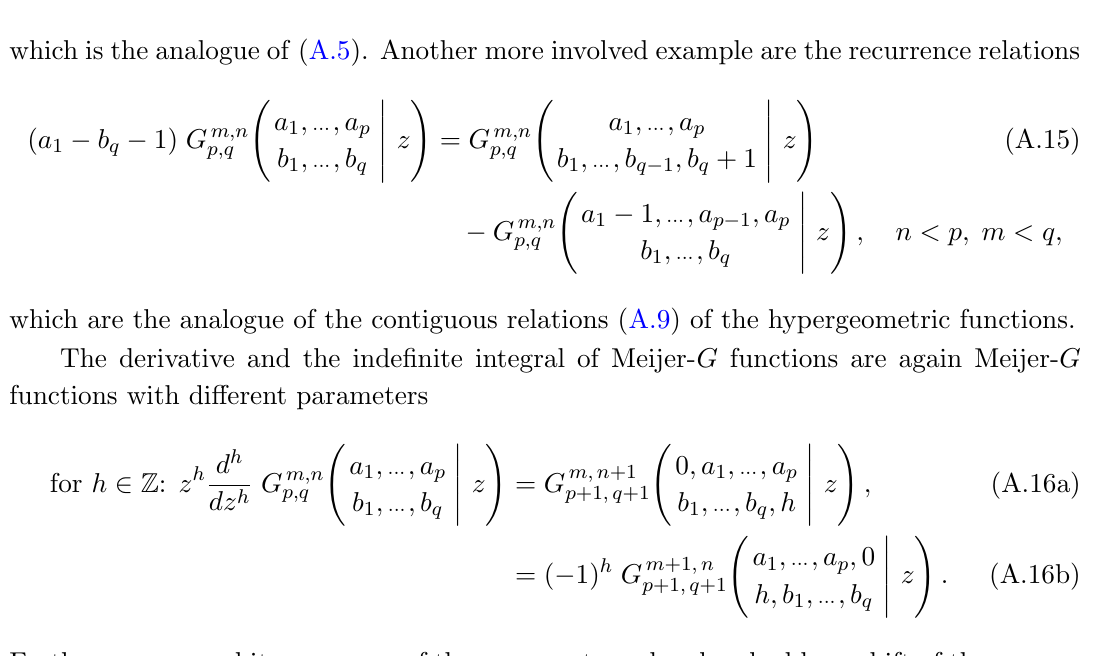
Figure 15. Boundary region and associated bulk surface. The strip has the width ‘ in direction x 1 and extends in(cid:12)nitely in the directions x i with i = 2 ; (cid:1) (cid:1) (cid:1) ; n . For regularisation, we take the (cid:12)nite width ~ ‘ (cid:29) ‘ . The transverse directions (i.e. x j with j = n + 1 ; (cid:1) (cid:1) (cid:1) ; d (cid:0) 1) are not